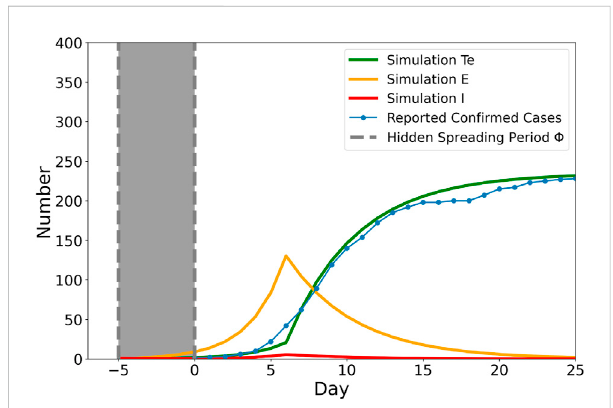
FIGURE 2 Simulation result with real Xi ’ an local resurgence data fi tted. The bluedottedlineshowstherealrecordedaccumulateddailycon fi rmed cases since Day 0. The green line is the simulated tested positive number with the implementation of lockdown once the number of reported con fi rmed case exceeds 40. β I = β E = 0.88, c = 1, w = 1/3, p = 0.8. The shaded area Φ = 5 hidden spreading period span was added to the real data to capture the delay of growth in simulation, indicating the possible initial infected individual started its hidden spreading period around 5 days